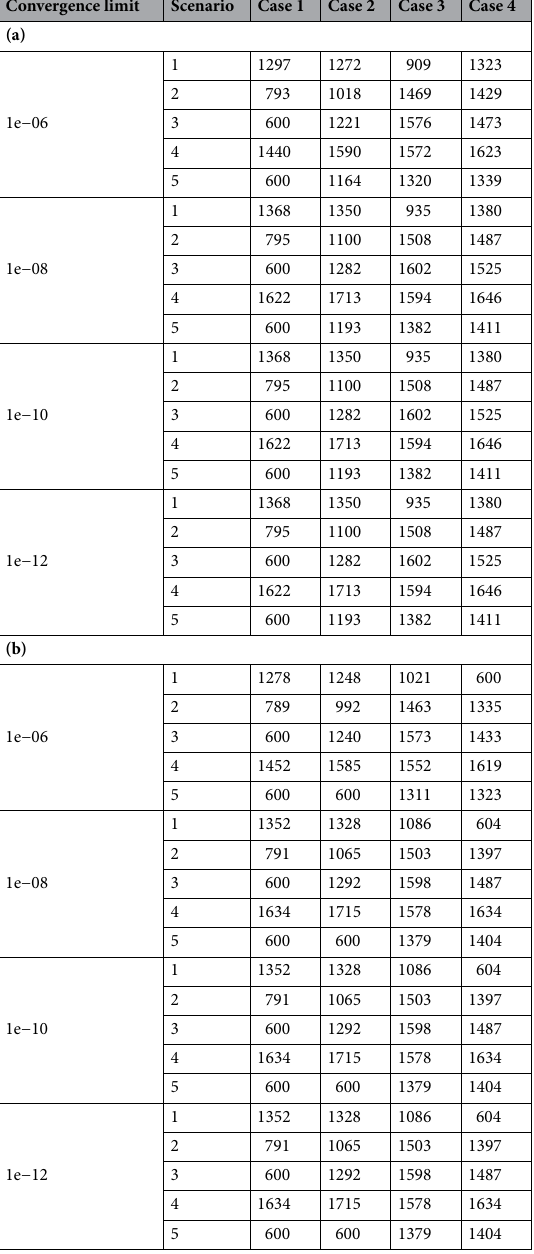
Table 4. Number of Mesh points during different scenario/cases for (a) Copper nanoparticles, (b) Silver